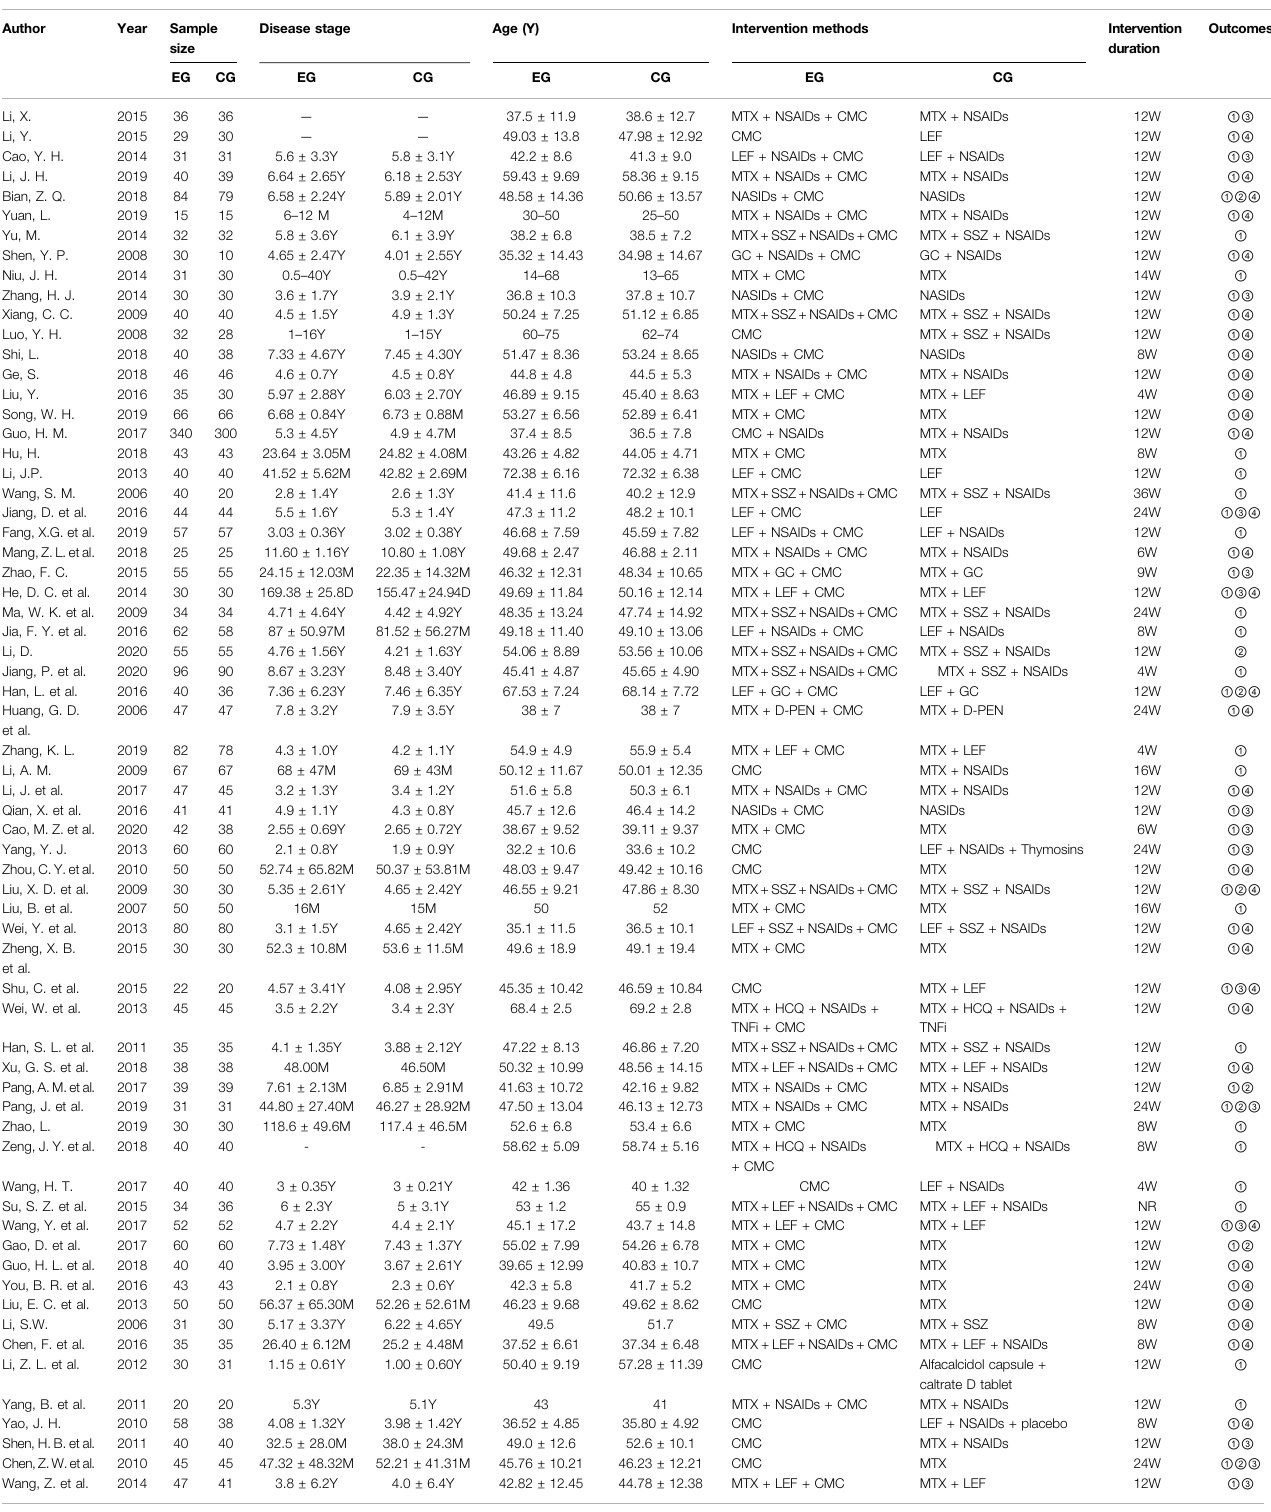
TABLE 1 | Characteristics of the included